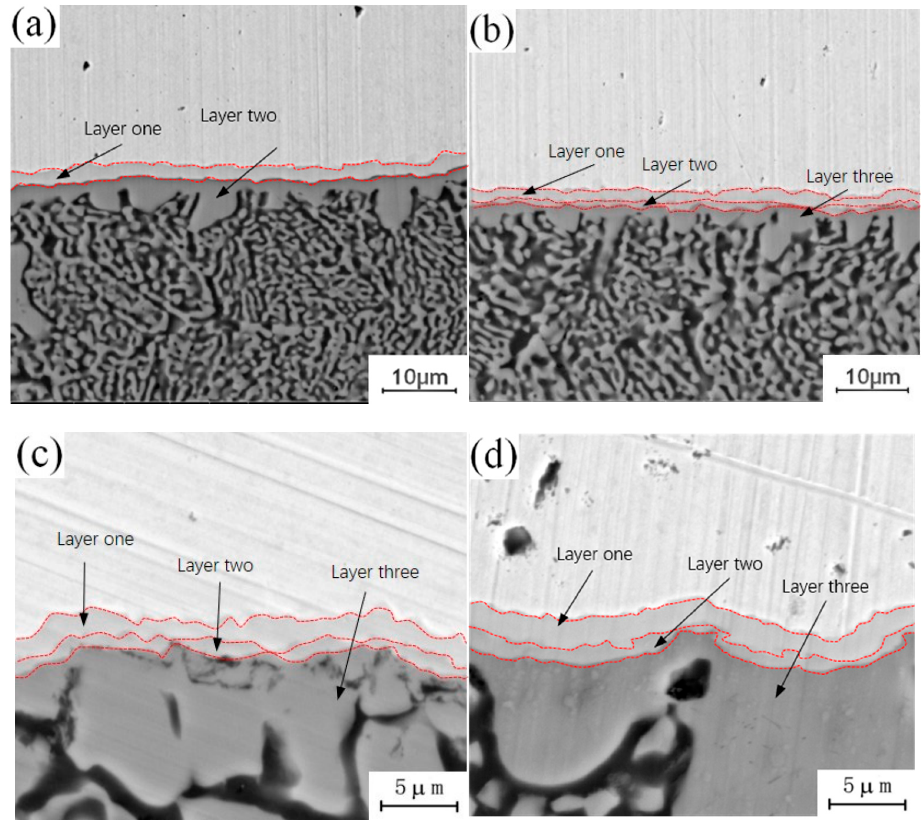
Figure 5. Microstructure of intermetallic compound (IMC) layer annealed at 350 °C for different holding times: ( a ) t = 0.5 h; ( b ) t = 1.5 h; ( c ) t = 3.5 h; ( d ) t = 4.5 h.